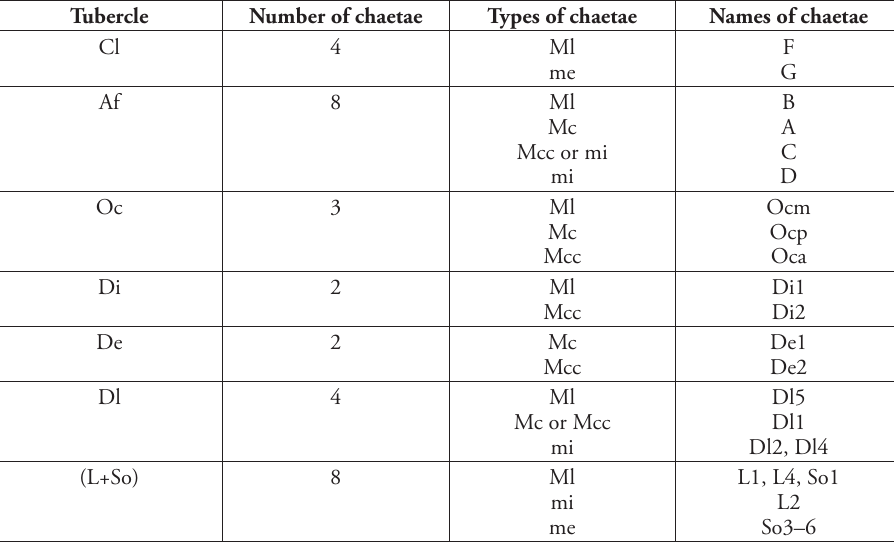
Table 1a. Chaetotaxy of Endonura longirostris sp. n.: cephalic chaetotaxy dorsal side. Tubercle